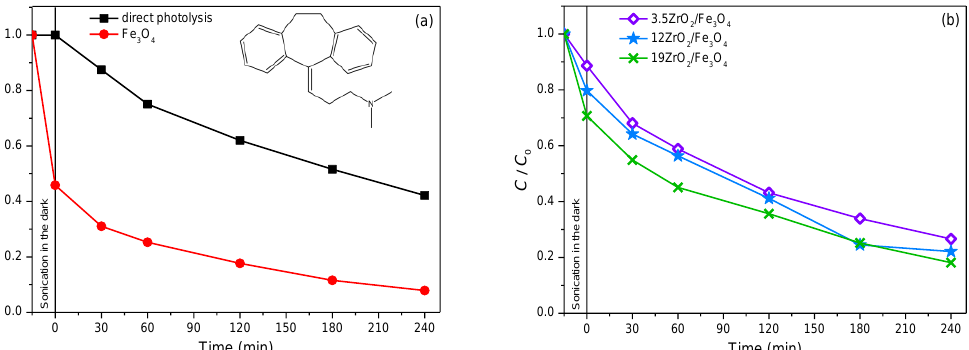
Figure 9. ( a )Kinetics of photolytic and photocatalytic degradation of amitriptyline (0.05 mmol/dm 3 ) in the presence of Fe 3 O 4 (1.0 mg/cm 3 ) as a photocatalyst, H 2 O 2 (45 mmol/dm 3 ), at pH 2.8 and using solar irradiation. Inset represents the structural formula of amitriptyline. ( b ) Kinetics of photocatalytic degradation of amitriptyline (0.05 mmol/dm 3 ) in the presence of different ZrO 2 /Fe 3 O 4 (1.0 mg/cm 3 ) as photocatalysts, H 2 O 2 (45 mmol/dm 3 ), at pH 2.8 and using solar irradiation.